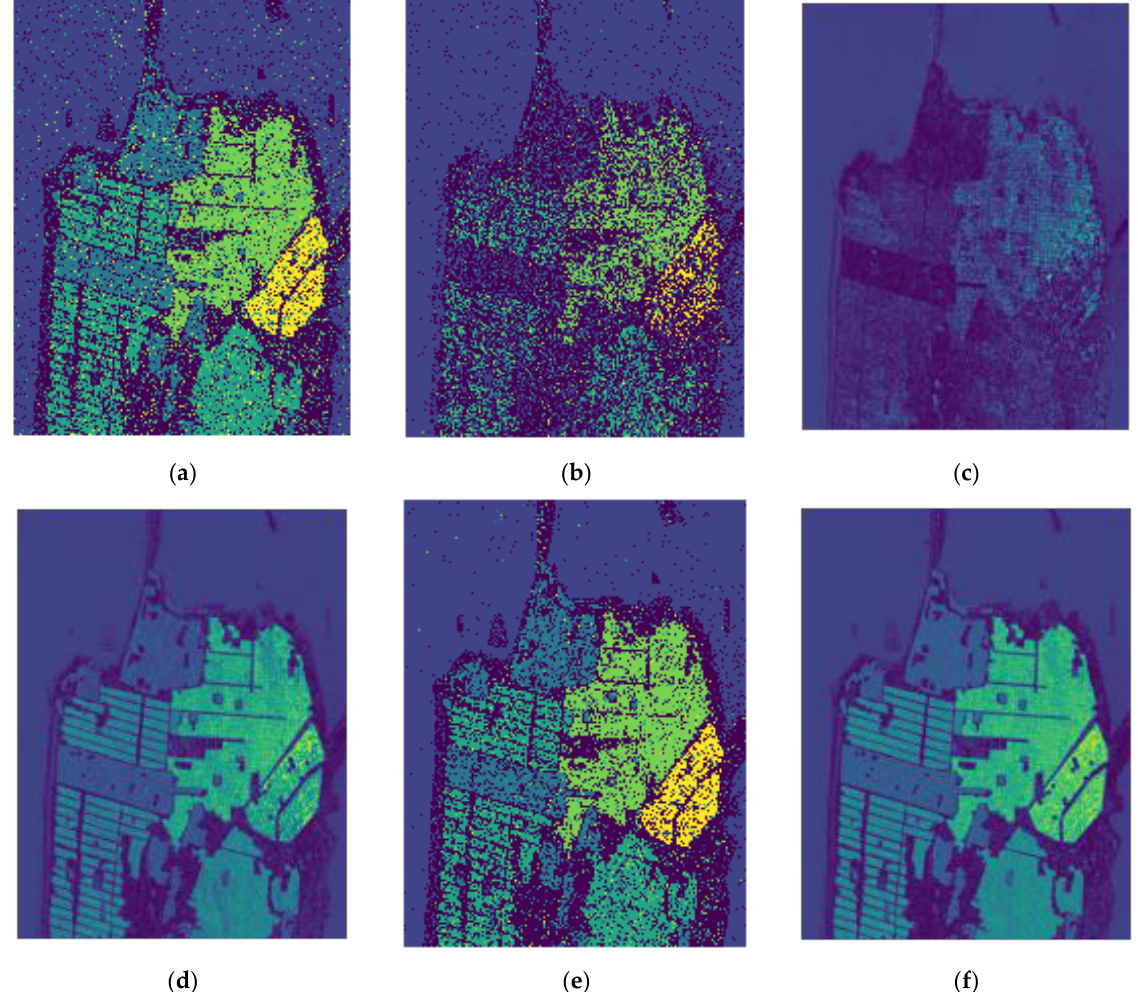
Figure 18. Classification results for San Francisco data. ( a ) DT, ( b ) AdaBoost, ( c ) GBM, ( d ) XGBoost, ( e ) Light GBM, and ( f ) RF.